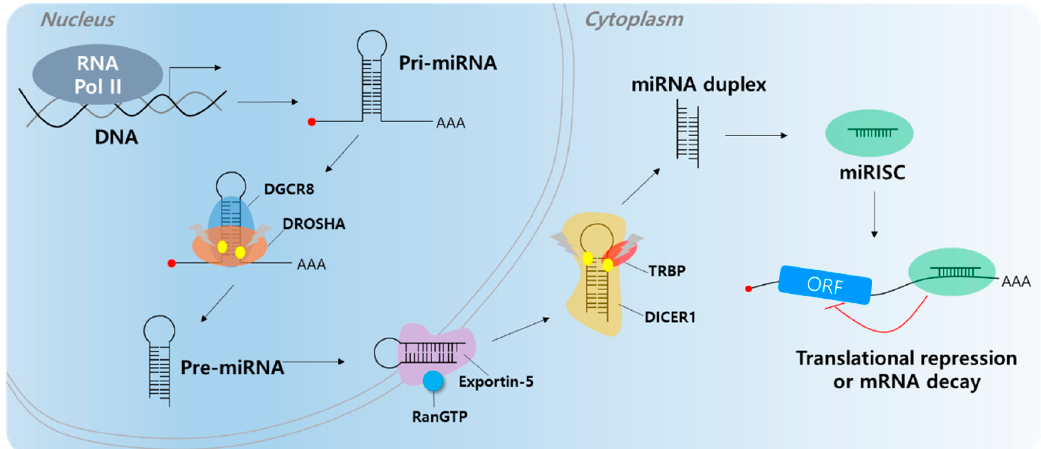
Figure 1. MicroRNA biogenesis. The primary miRNA (pri-miRNA) is transcribed by RNA polymerase II (RNA Pol II). The microprocessor complex, Drosha and DiGeorge Syndrome Critical Region 8 (DGCR8), cleaves the pri-miRNA to produce the precursor miRNA (pre-miRNA). The pre-miRNA translocates to the cytoplasm in an Exportin-5 / RnaGTP-dependent manner. TAR RNA-binding protein (TRBP) and Dicer1 cleave the pre-miRNA to produce the mature miRNA duplex. The 5p or 3p of the miRNA duplex is loaded into the miRNA-induced silencing complex (miRISC). Finally, the miRISC binds to target mRNAs to induce translational repression or mRNA decay.